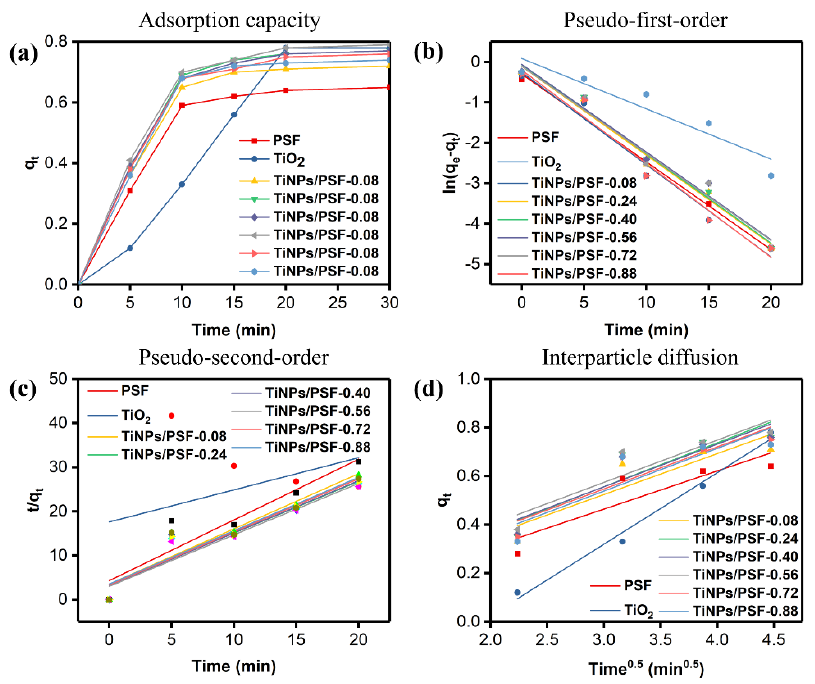
Figure 5. The adsorption capacity ( a ), pseudo-first-order model ( b ), pseudo-second-order model ( c ) and intraparticle diffusion model ( d ) of different samples for methylene blue.